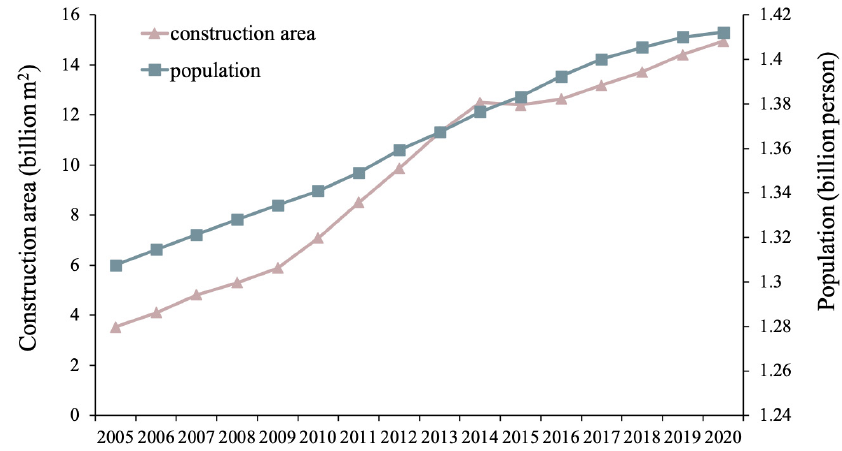
Figure 4. Population and construction area in China from 2005 to 2020.